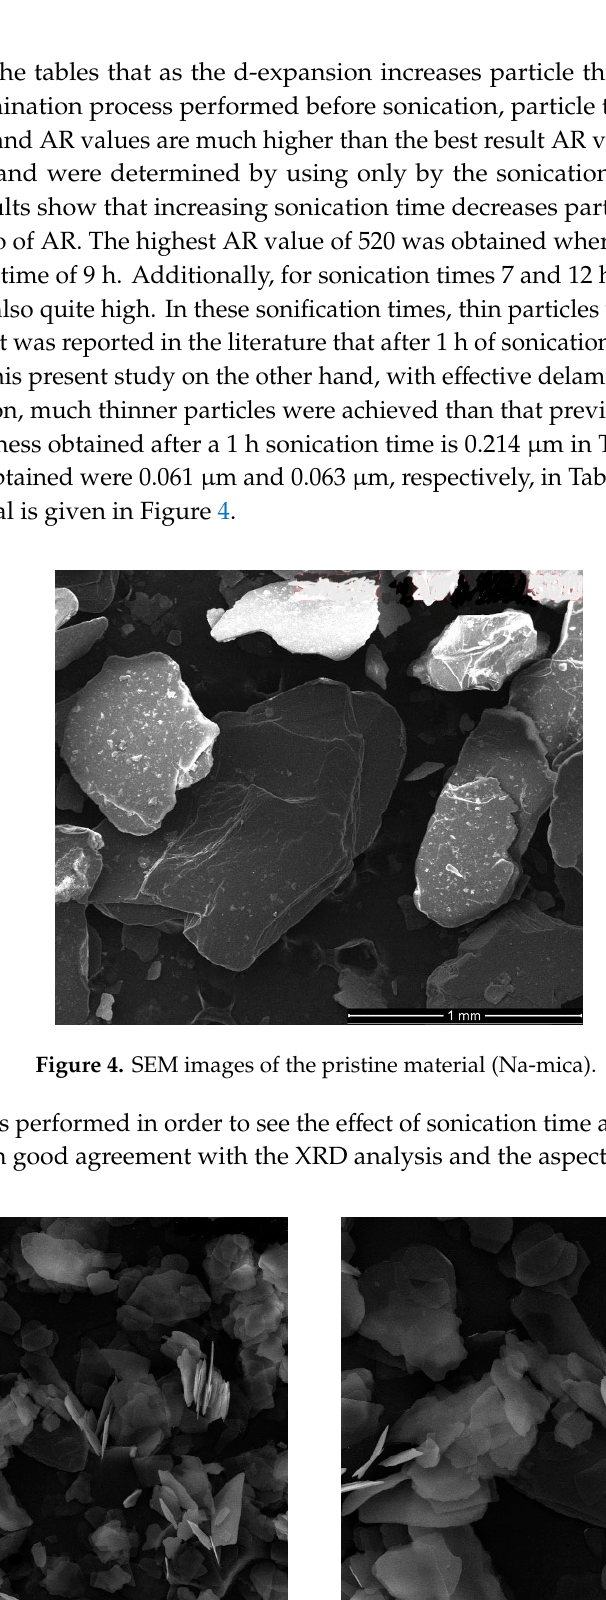
Table 9. a , c , AR values for sample M X2C2 ( d = 51 Å).